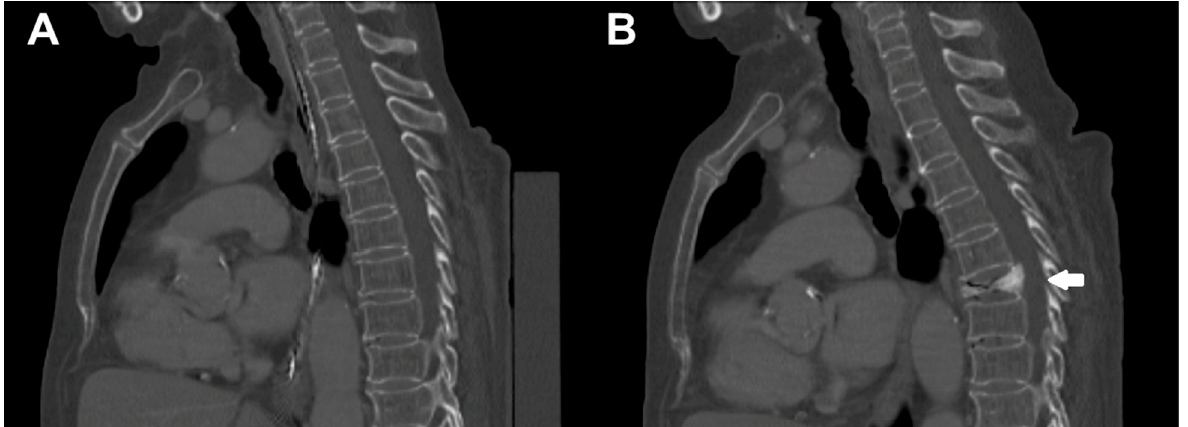
Figure 2. Illustrative patient case. This figure depicts sagittal reformations of the spine of a 78-year-old female patient ( A ) at baseline and ( B ) during follow-up imaging by multi-detector computed tomography (MDCT). During the interval of 8 months between baseline and follow-up scanning, the patient sustained an incidental osteoporotic vertebral fracture (VF) of T7 ( white arrow ).